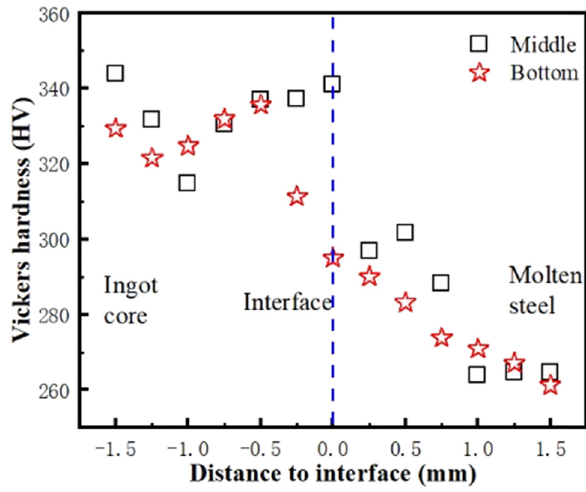
Figure 14: Microhardness near the